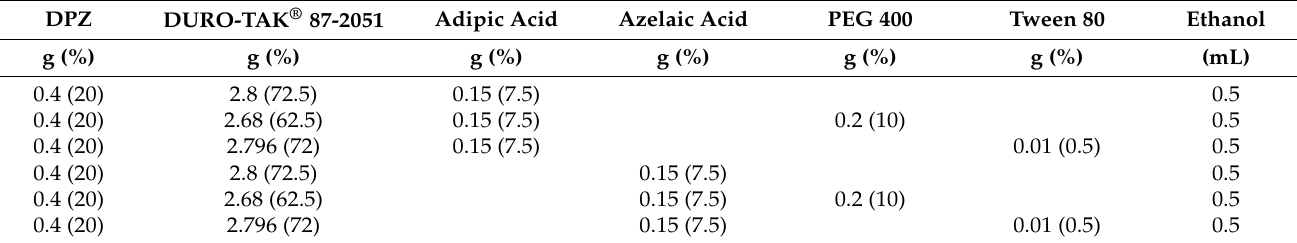
Table 4. DPZ IL patch formulation using DURO-TAK ® 87-2051.